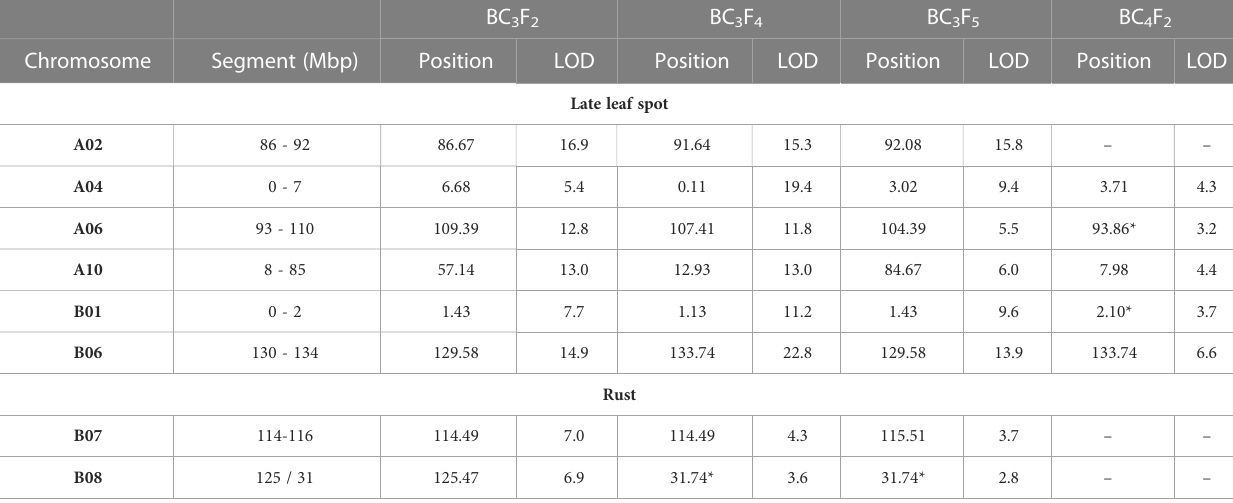
TABLE 3 Quantitative trait loci identi fi ed for late leaf spot and rust resistance on populations of four generations (BC 3 F 2 , BC 3 F 4 , BC 3 F 5 and BC 4 F 2 ) derived from the cross ‘ IAC OL 4 ’ × ( A. magna K 30097 × A. stenosperma V 15076) 4x using the non-parametric interval mapping in R/qtl and a signi fi cance level of 1%, except the four QTLs with an asterisk (*) that were identi fi ed at